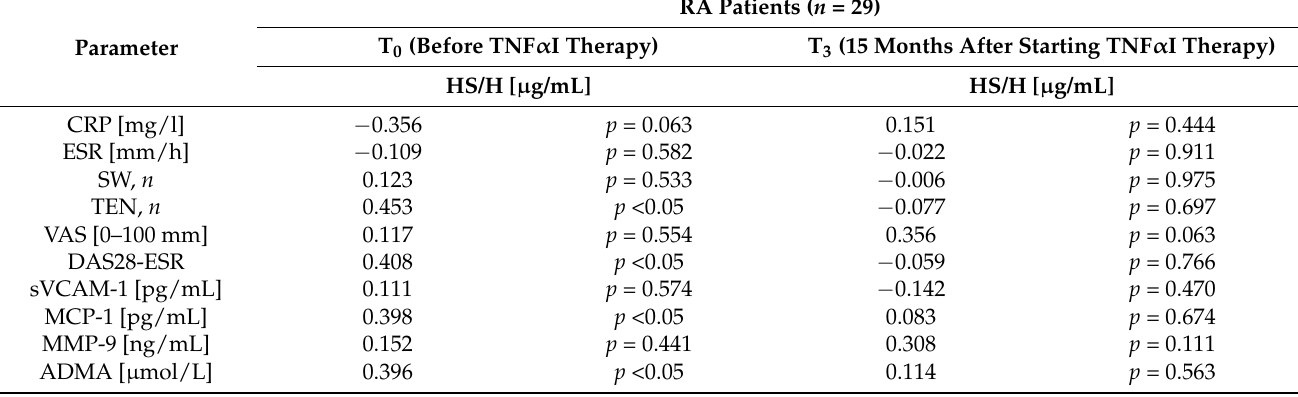
Table 4. Relationship between circulating levels of heparan sulfate/heparin (HS/H) and clinical and laboratory indicators of disease activity, as well as markers of endothelial dysfunction (sVCAM-1, MCP-1, MMP-9 and ADMA), in patients with rheumatoid arthritis (RA) before and after 15-month anti-TNF- α